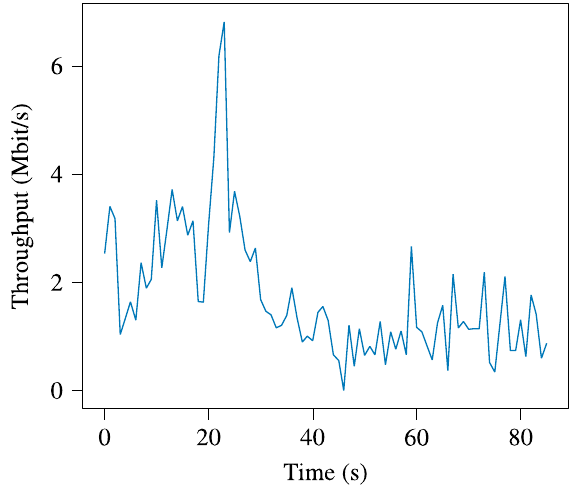
Figure 7. Service channel throughput during H8’s attack of H2 and H5.